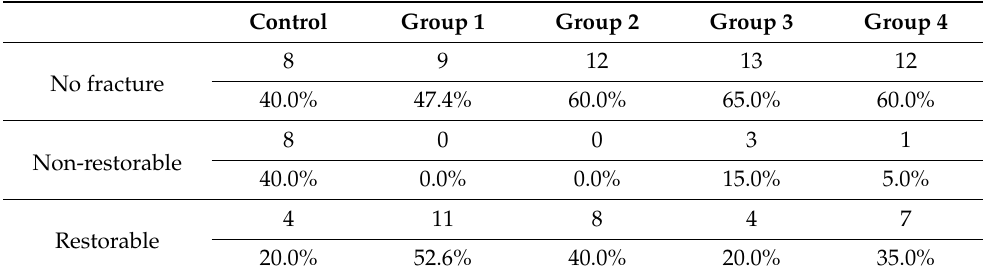
Table 2. The distribution of fracture patterns among the tested groups (n =